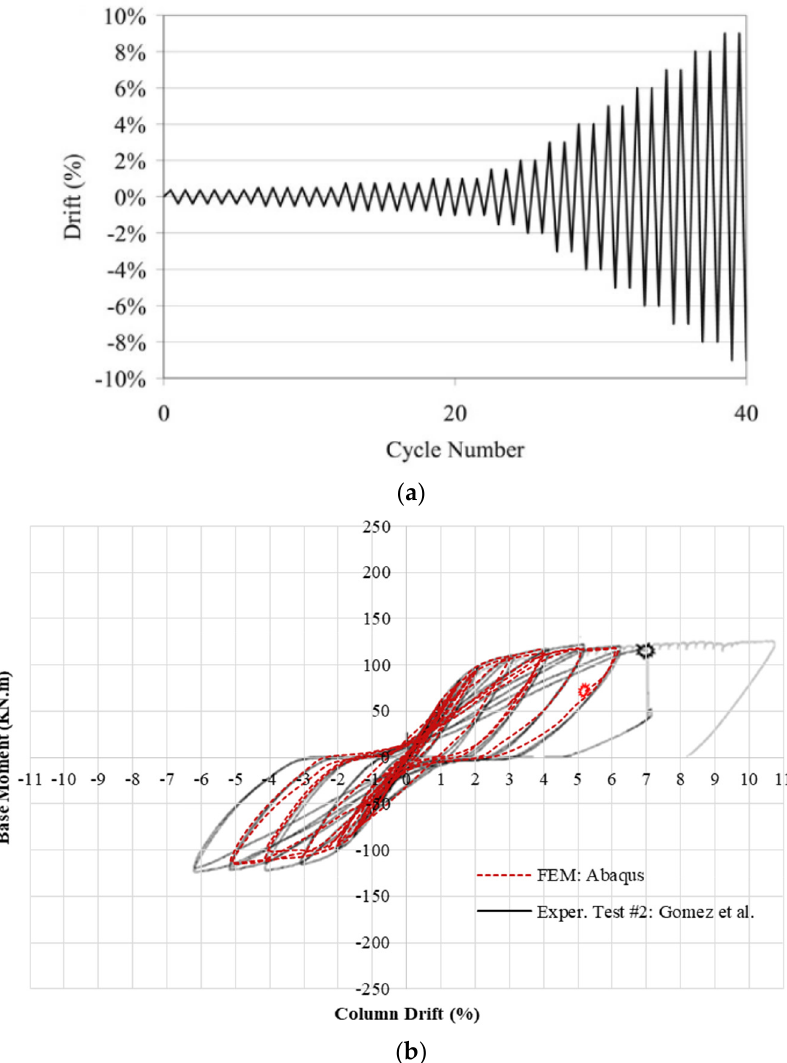
Figure 7. Validation of the second specimen: ( a ) cyclic loading protocol and ( b ) base moment vs. column drift for the FE and experimental